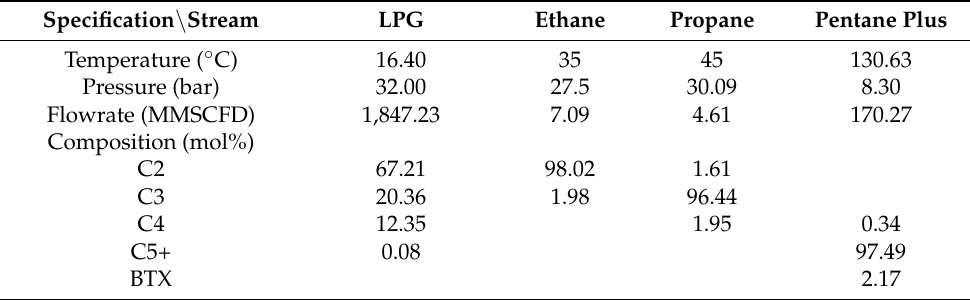
Table 10. Fractionation unit conditions and specifications.